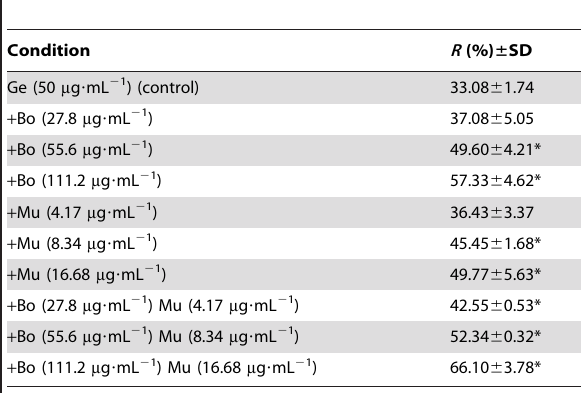
Table 3. Fluorescence recovery rate after treatment with borneol (Bo) and muscone